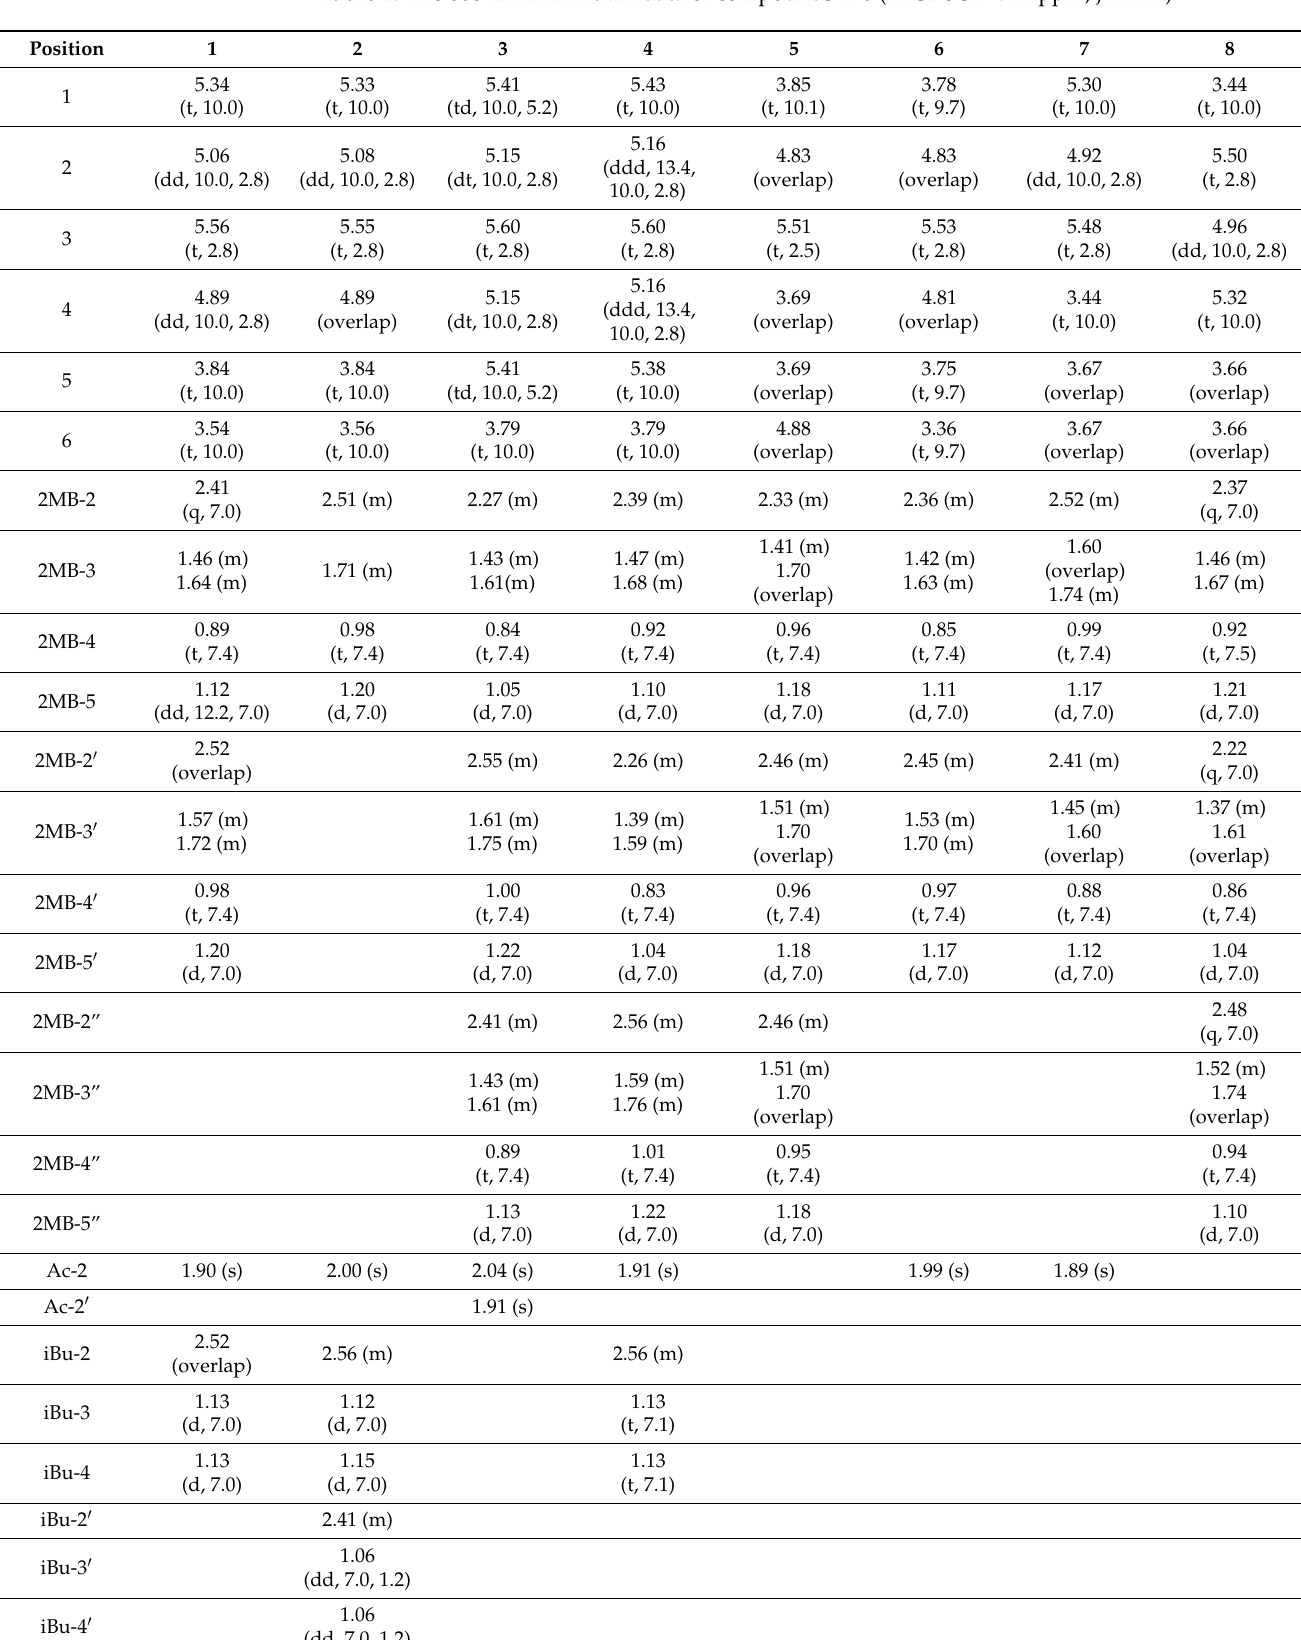
Table 1. The 600 MHz 1H-NMR data of compounds 1 – 8 (in CD3OD δ in ppm, J in